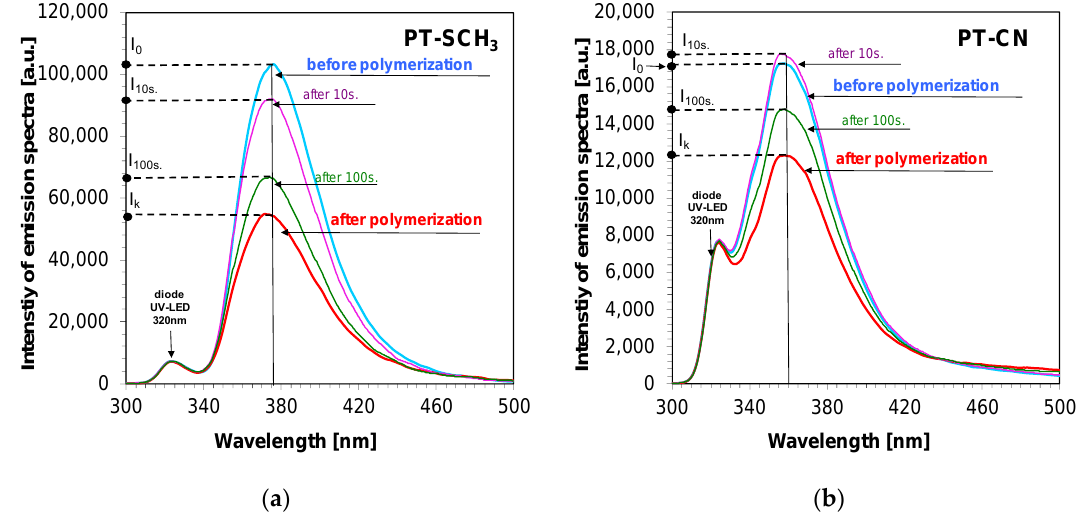
Figure 7 . Changes of fluorescence spectra during free-radical photopolymerization of the TMPTA monomer under irradiation of 320 nm: ( a ) 2,6-bis(4-methylsulphanylphenyl)pyridine (PT-SCH 3 ); ( b ) 2,6-bis(4-cyanophenyl)pyridine (PT-CN).